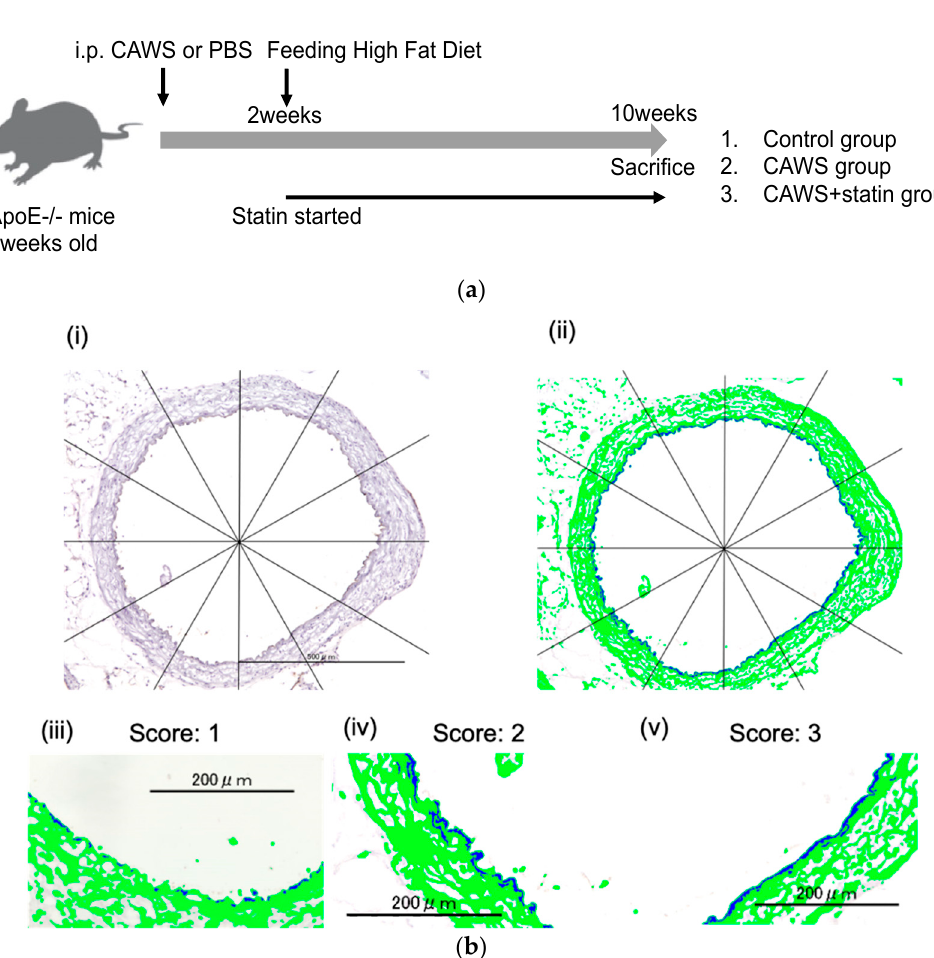
Figure 4. Experimental procedure. ( a ) 4 mg of CAWS was intraperitoneally injected into each 5-week-old ApoE-/- mouse for five consecutive days to induce Kawasaki disease-like vasculitis. Two weeks after administering CAWS, the mice were switched to a high-fat diet to promote atherosclerosis. Daily statin doses (10 mg/kg/day) were administered beginning two weeks after CAWS administration and until the end of the experiment. Mice were sacrificed and assessed 10 weeks after CAWS administration. This schematic illustration was modified from our previous published study [8]. ( b ) Assessment of the horizontal transection area of the ascending aorta (bar, 200 μ m). eNOS-